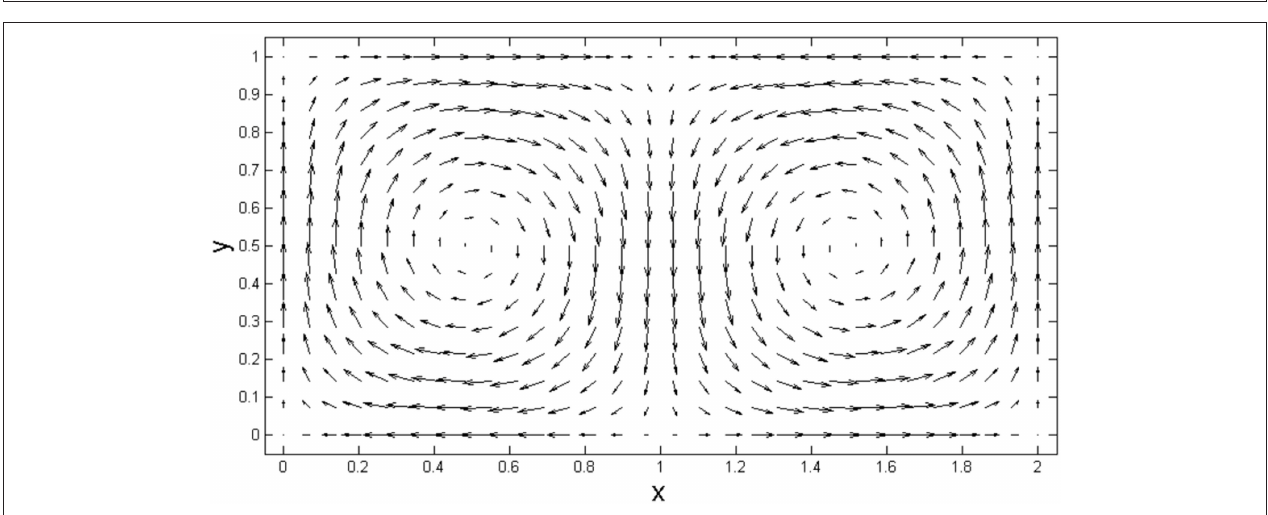
FIGURE 2 | Phase portrait of the wind-driven double-gyre model at t